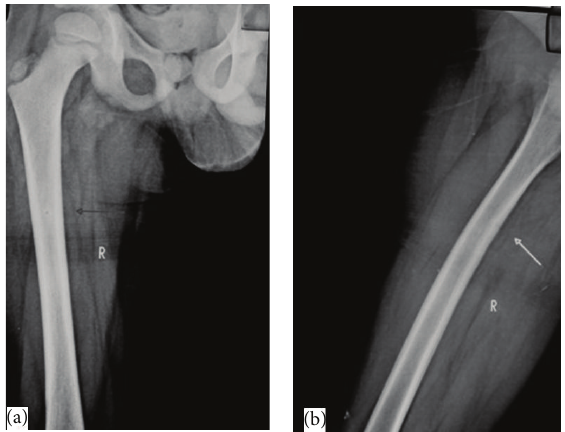
Figure 3: Plain radiograph AP (a) and lateral (b) views of the right femur done after 6 weeks show no significant change in the appearance of lucent bony defect noted along the medial cortex of the right